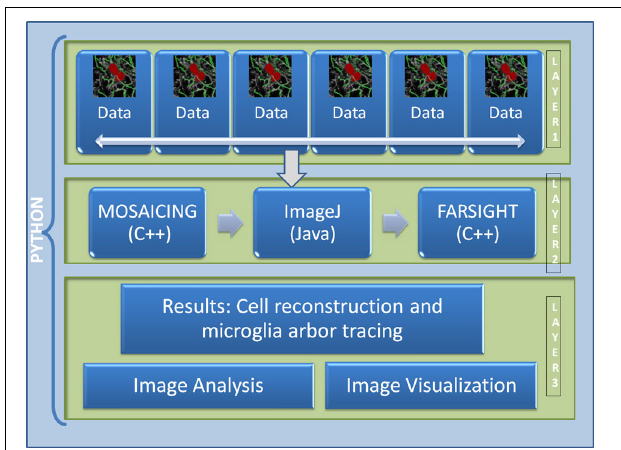
FIGURE 2 | Architecture of the proposed pipeline. Layer 1 is the data layer which consist of the overlapping tiles acquired by the motorized microscope, Layer 2 consists of all the image processing and feature extraction algorithms, Layer 3 is the result visualization and analysis